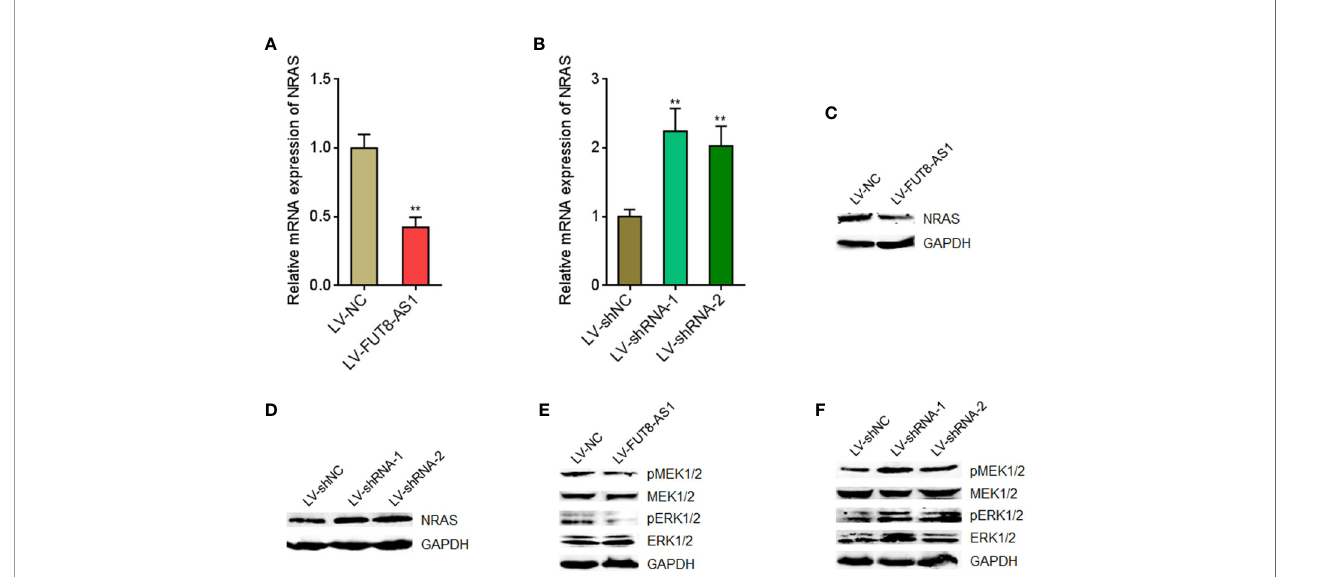
FIGURE 6 | FUT8-AS1 represses NRAS/MAPK signaling. (A) NRAS mRNA expression levels in SK-MEL-2 cells overexpressing FUT8-AS1 or control were measured by real-time PCR. (B) NRAS mRNA expression levels in CHL-1 cells silencing FUT8-AS1 or control were measured by real-time PCR. (C) NRAS protein levels in SK-MEL-2 cells overexpressing FUT8-AS1 or control were measured by western blot. (D) NRAS protein levels in CHL-1 cells silencing FUT8-AS1 or control were measured by western blot. (E) Phosphorylation levels of MEK1/2 and ERK1/2 in SK-MEL-2 cells overexpressing FUT8-AS1 or control were measured by western blot. (F) Phosphorylation levels of MEK1/2 and ERK1/2 in CHL-1 cells silencing FUT8-AS1 or control were measured by western blot. Data are presented as mean ± SD. ** P < 0.01 by two-tailed unpaired t test (A) or one-way ANOVA followed by Dunnett ’ s multiple comparisons test (B)